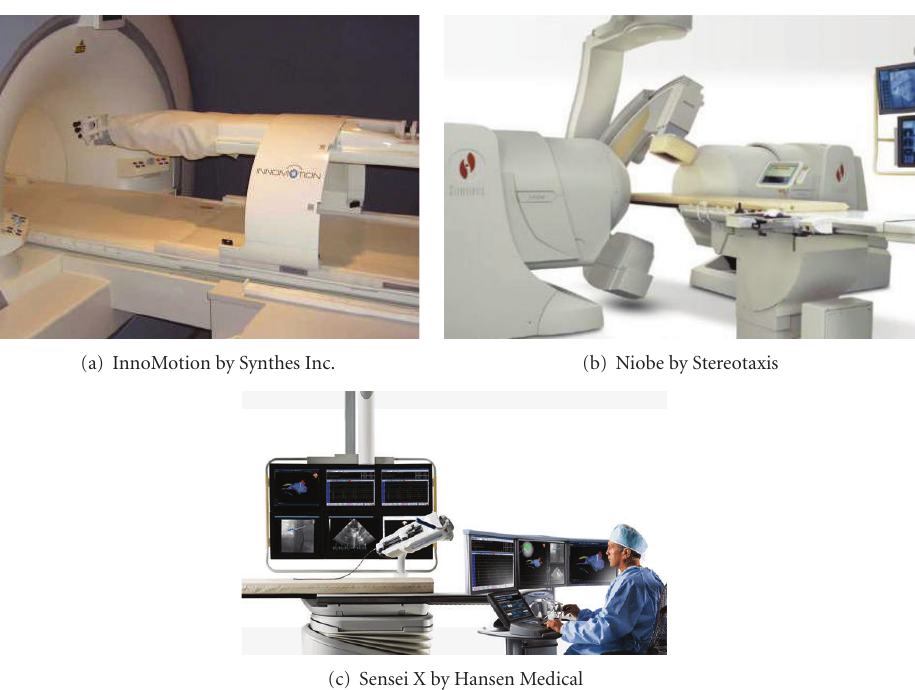
Figure 4: Real-time image guided percutaneous (a) and catheter robots ((b) and (c)). The InnoMotion image is ©2012 Synthes Inc. The Niobe image is ©2012 Stereotaxis. The Sensei X image is ©2012 Hansen